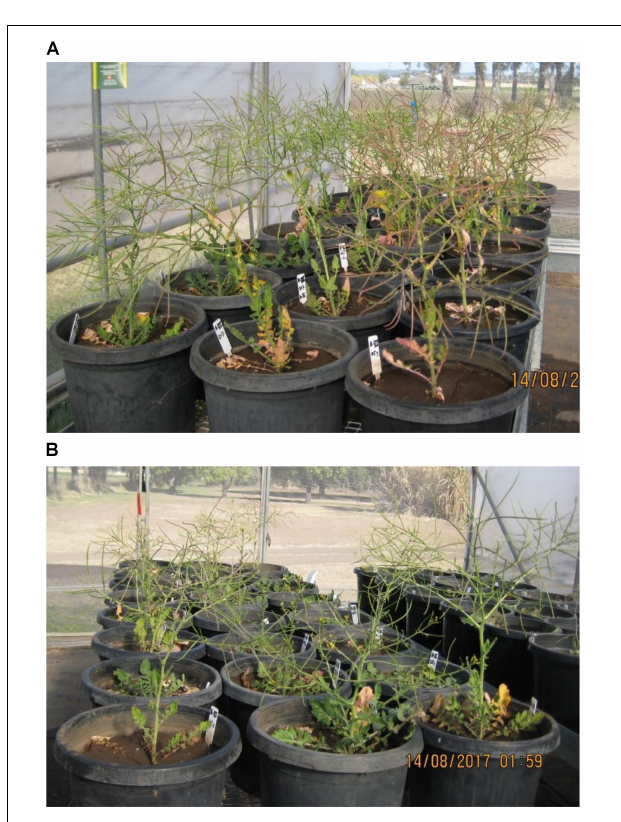
FIGURE 1 | St. George biotype (A) and Dalby biotype (B) of African turnip under different water regimes in naturally ventilated greenhouse.